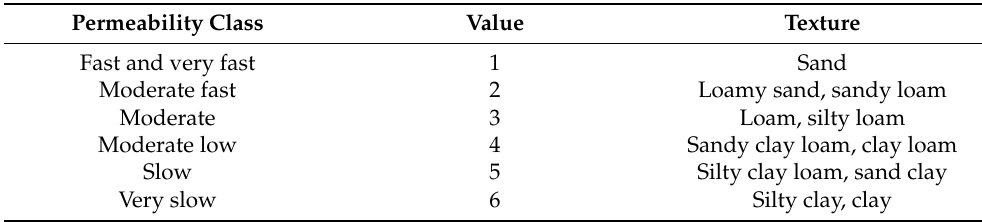
Table 5. Soil permeability classes are estimated from major soil textural classes. Permeability Class Value